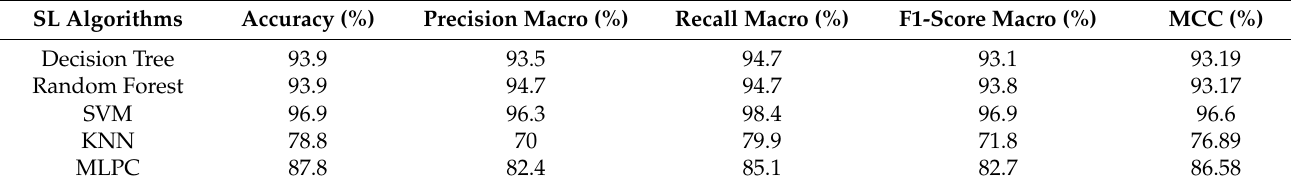
Table 4. Model metric resuts for the first simulation (KPIs).